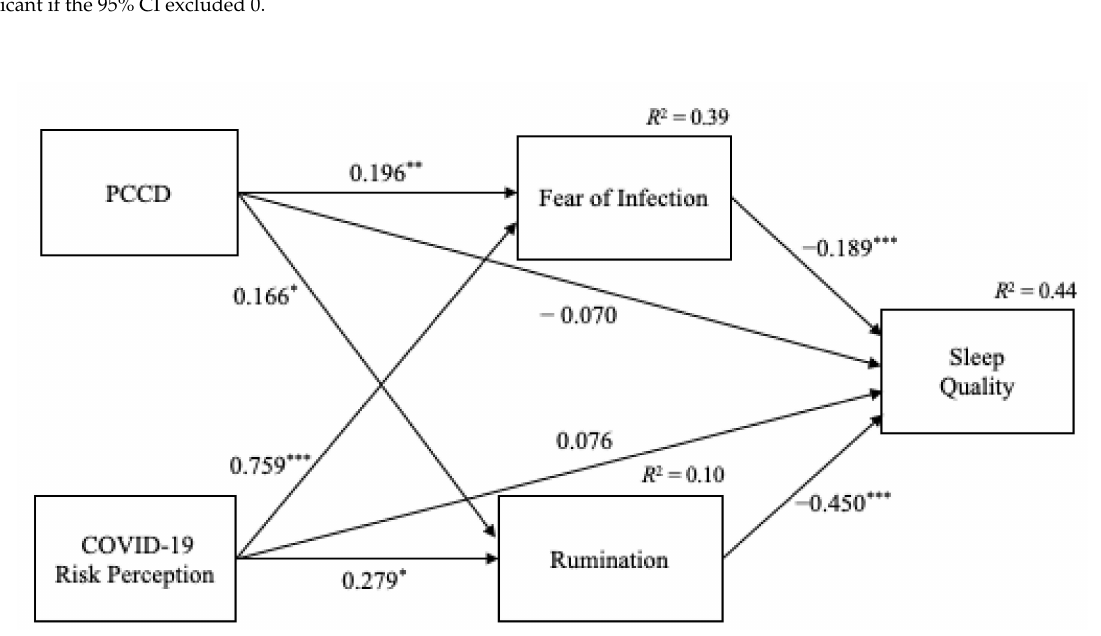
Figure 1. Mediation model. Note. The direct effect (standardized coefficients) of each path. * p < 0.05. ** p < 0.01. *** p < 0.001. Age, gender and marital status were entered as control variables (not shown in the